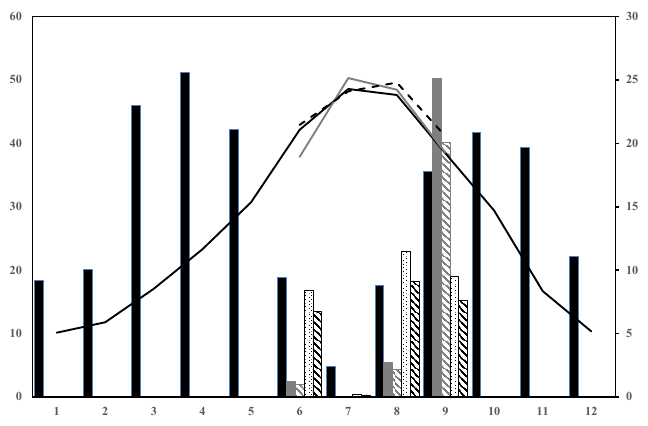
Figure 1. Climogram representing monthly average precipitation (grey bars, left Y axis) and temperature (black line, right Y axis) based on the 25-year period data obtained from the Pozo-Cañada (Albacete, Spain) weather station. Black bars and line: precipitation and mean monthly temperature for 1987–2012; Dark grey bars and line: precipitation and mean monthly temperature for the 2010 drought period months. Bars filled in dark grey diagonal lines: precipitation, including induced drought for the 2010 drought period months. Dashed black line and dotted black bars: precipitation and mean monthly temperature for the 2011 drought period months. Bars filled in black diagonal lines: precipitation including induced drought for the 2011 drought period